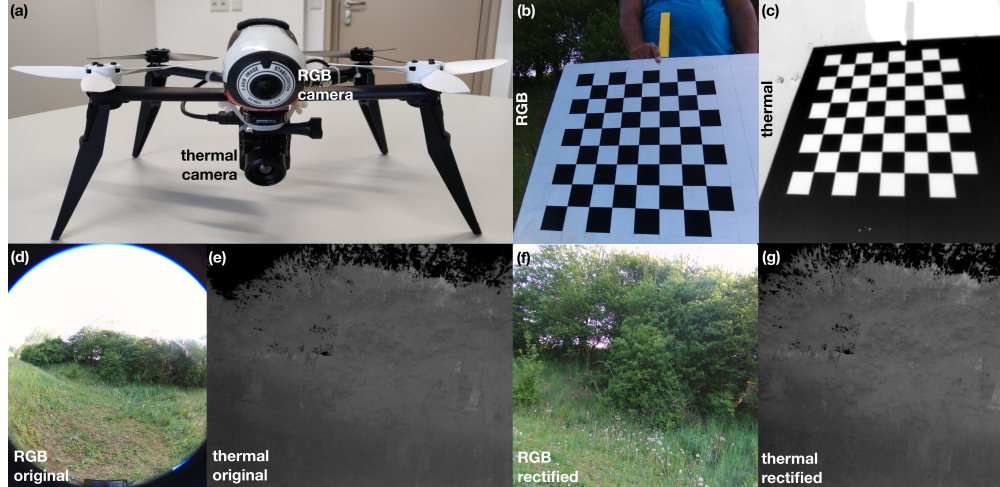
Figure 2. Camera drone with RGB and thermal cameras ( a ), calibration pattern captured from RGB ( b ) and thermal ( c ) cameras, original RGB ( d ) and thermal ( e ) images, rectified RGB ( f ) and thermal ( g )